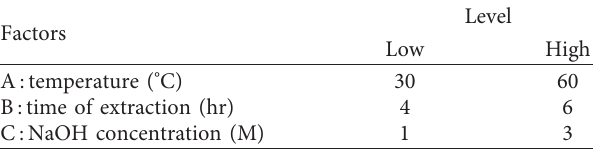
Table 1: Factors and their levels used for the